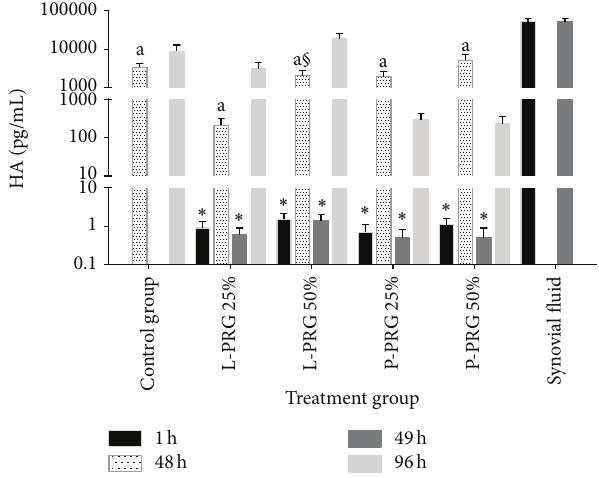
Figure 6: a Lowercase letters denote significant ( 𝑃 < 0.05 ) differencesbetweengroupsinthesamecolumnbyTukeytestat48 h. Significantly different with a: SF. ∗ Significant differences ( 𝑃 < 0.05 ) between the same variable at 1 h and 48 h and at 49 h and 96 by 𝑡 - paired test. § Significant differences ( 𝑃 < 0.05 ) between the same variable at 48 and 96 h by Tukey